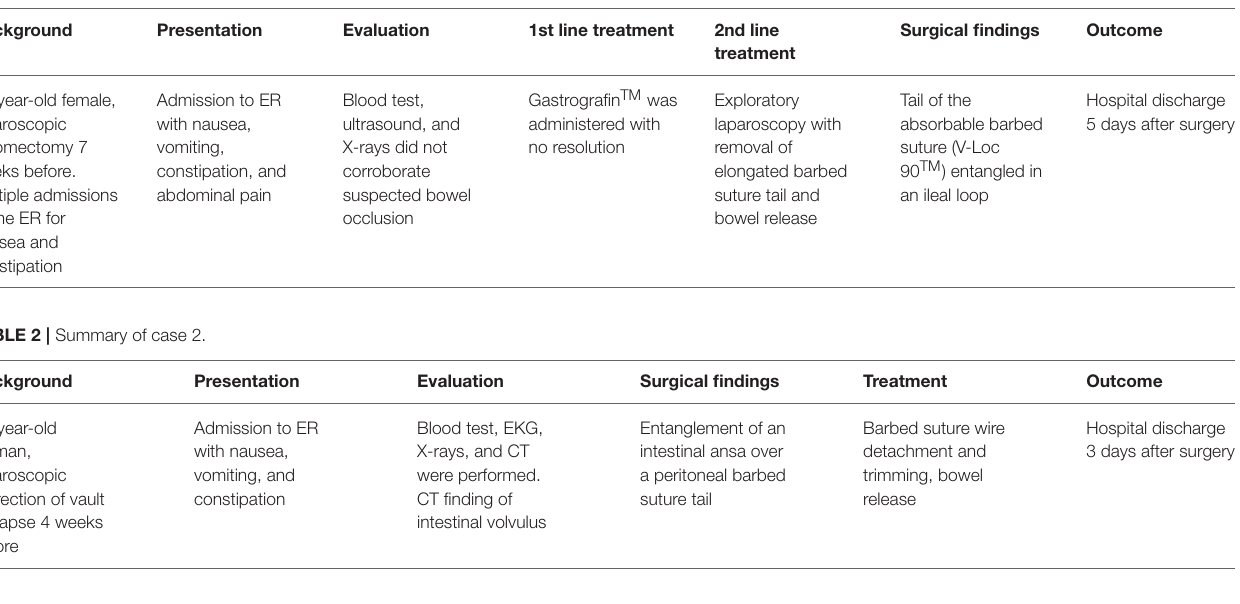
TABLE 1 | Summary of case 1.